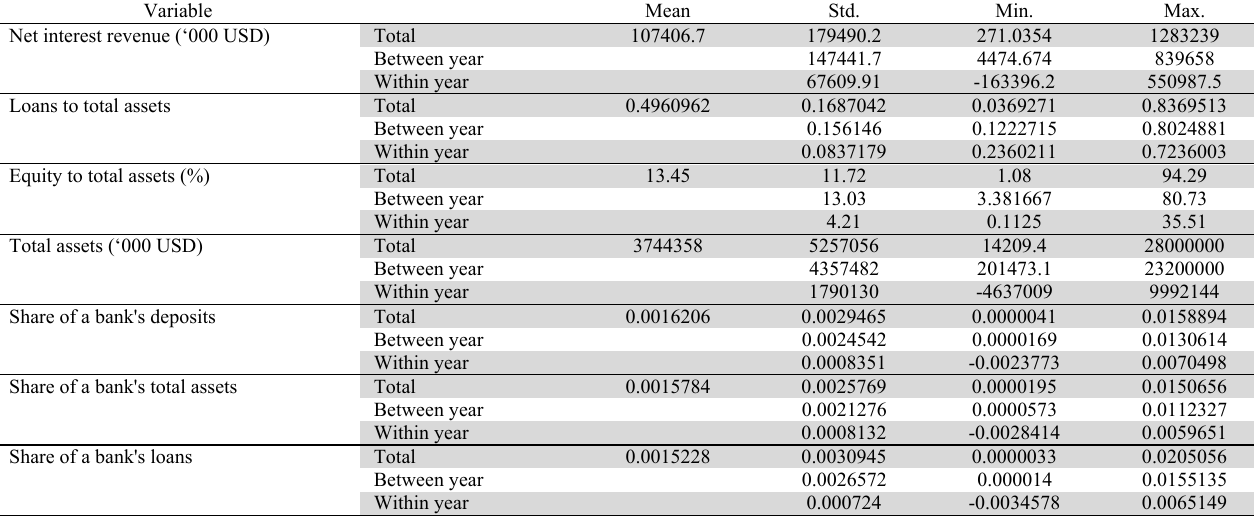
Statistical description in model 3.2, 2005-2012